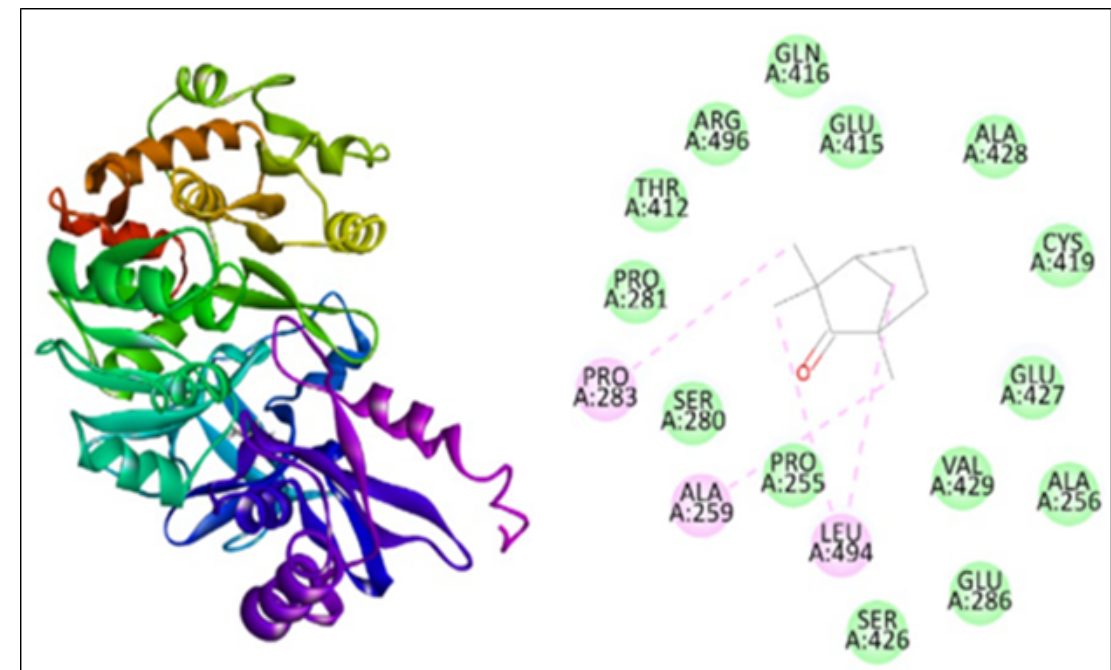
Figure 4. Interaction of β‐ ketoacyl acyl carrier protein synthase I with fenchone.